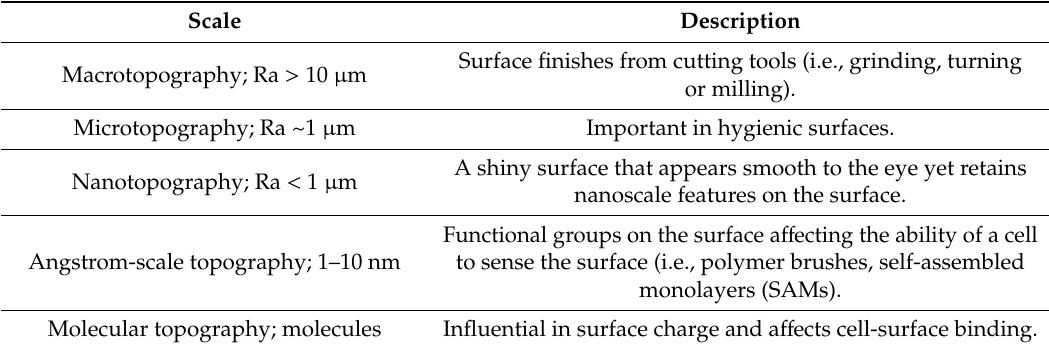
Table 2. Description of the di ff erent scale length topographies observed in common antifouling materials [65]. Scale Description Surface finishes from cutting tools (i.e., grinding, turning Macrotopography; Ra > 10 µ m or